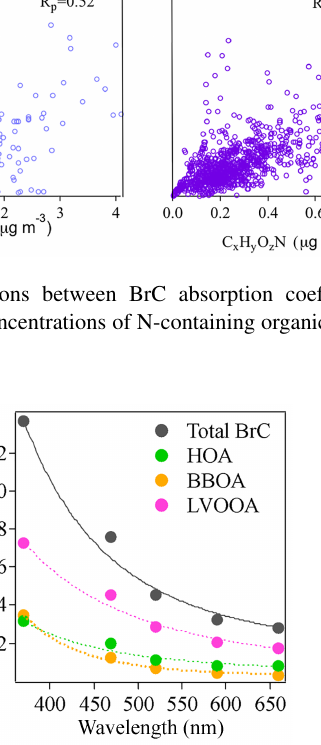
Figure 7. Exponential decay of b abs for total BrC and different light-absorbing OA components across wavelengths.